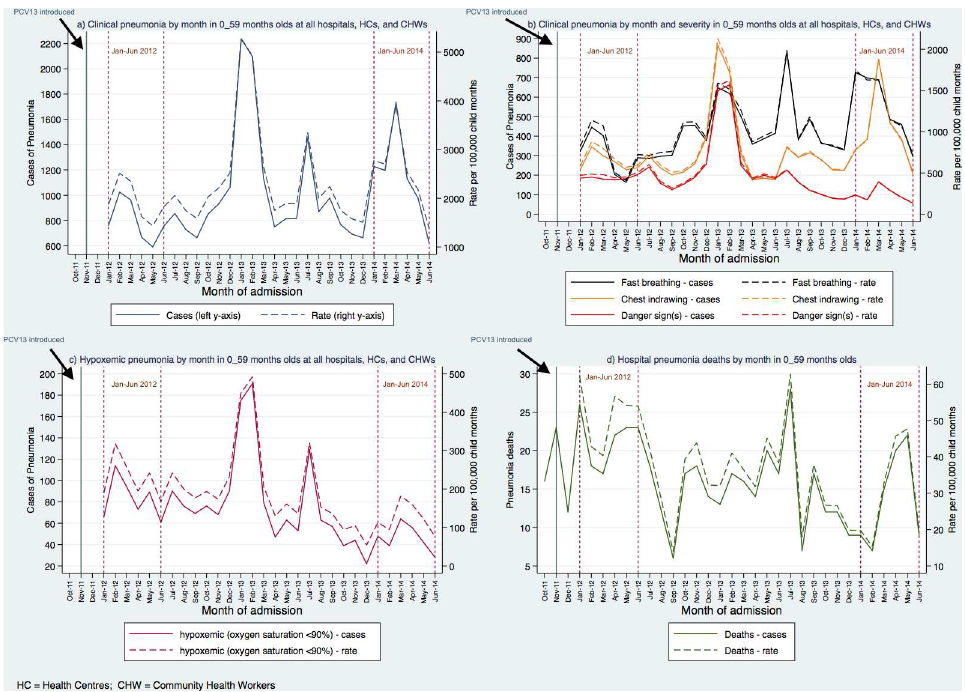
Fig 2. Pneumonia cases and deaths in children under 5 yearsold by month: January 2012–June 2014: a) Total clinical pneumonia cases at all hospitals,healthcentres and community health worker clinics b) Clinical pneumoniacases at all hospitals,health centres and community health worker clinics by category c) Hypoxemic pneumoniacases at all hospitals,health centres and community health worker clinics d) Hospitalpneumonia